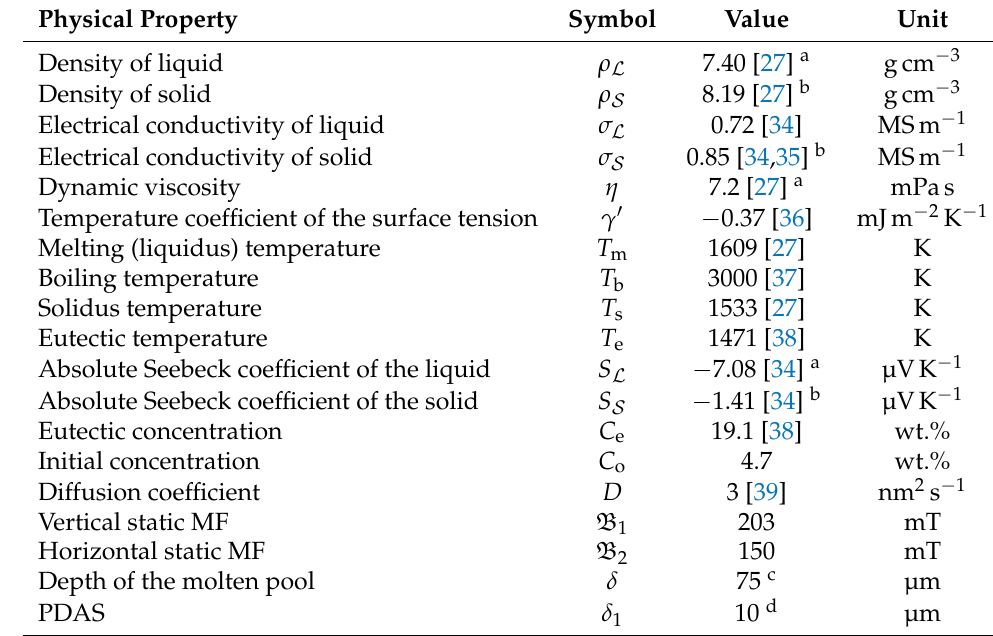
Table 2. Physical properties of Inconel 718 and other parameters used for the